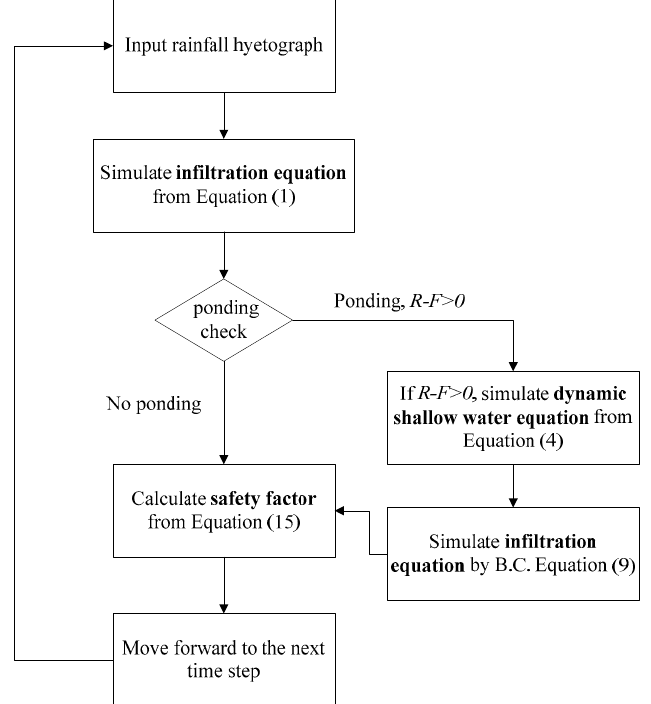
Figure 1. Flow chart of the model developed in this study.